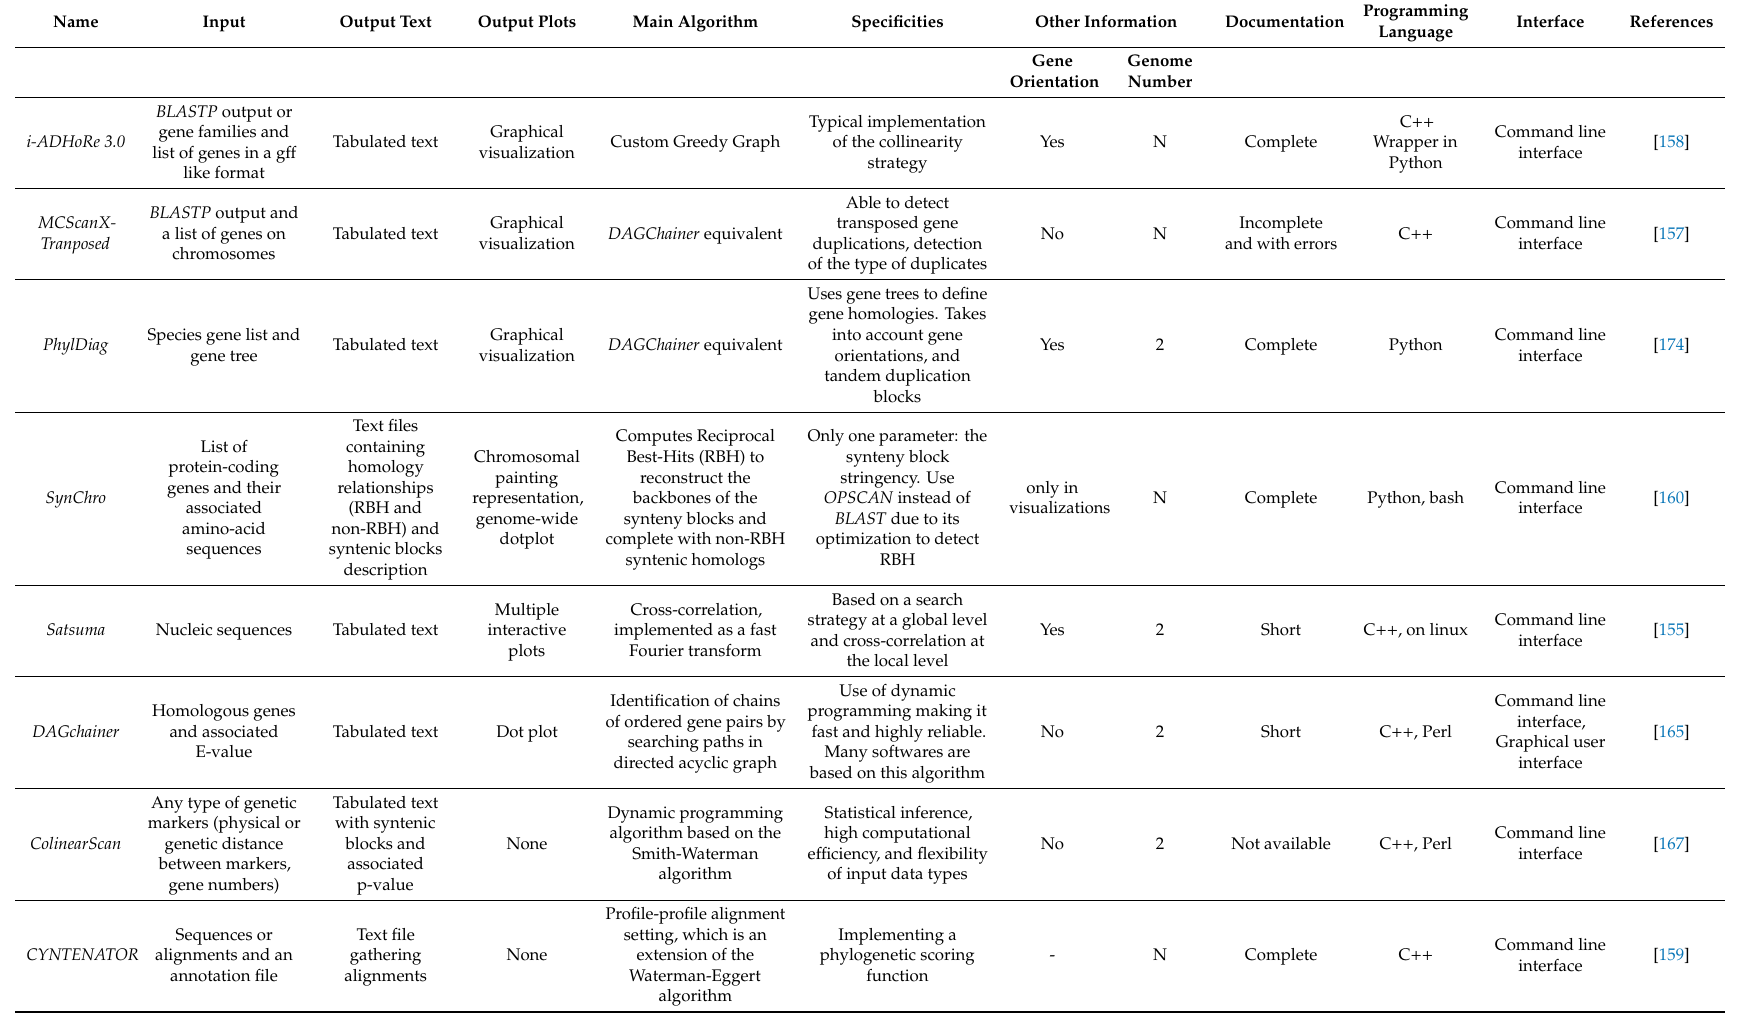
Table 2. Summary of the characteristics of di ff erent existing tools for identifying syntenic